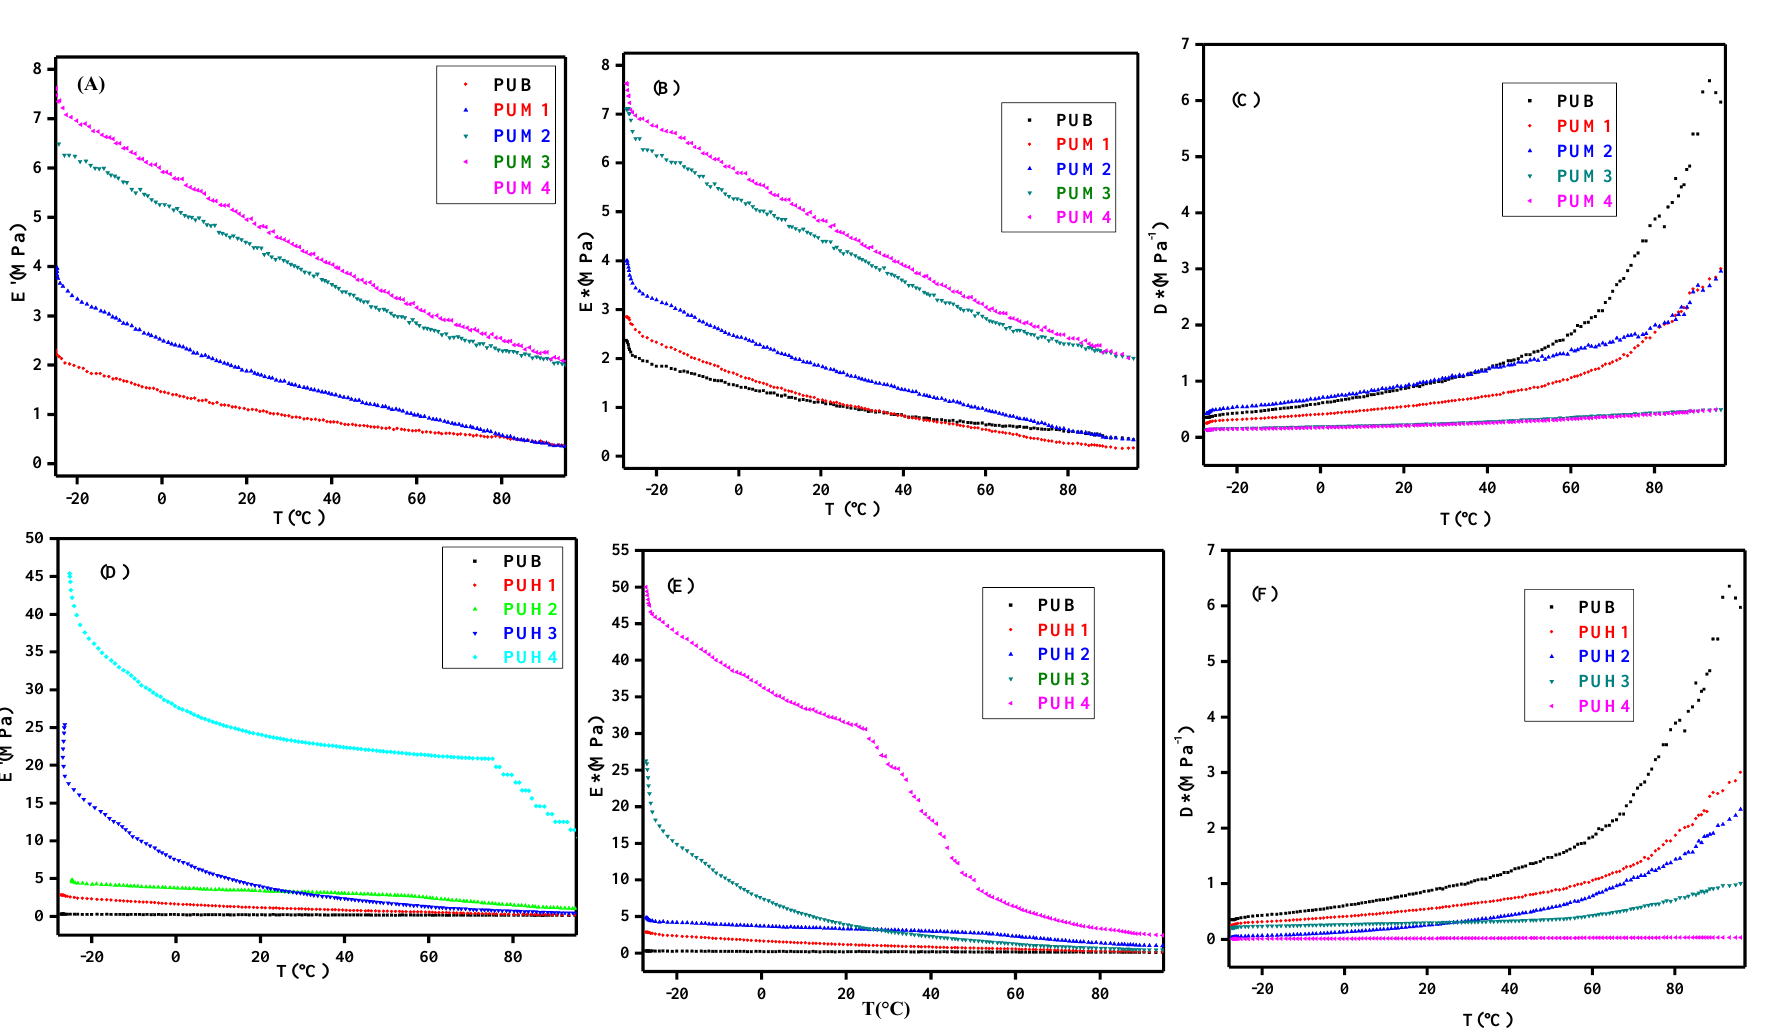
Figure 4. Mechanical Behavior of GO induced PU composites for PUM and PUH series. ( A ) Relationship of storage modulus and temperature of PUM. ( B ) Relationship of storage modulus and temperature of PUM complex modulus. ( C ) Relationship of compliance complex and temperature of PUM. ( D ) Relationship of storage modulus and temperature of PUH. ( E ) Relationship of complex modulus and temperature of PUH. ( F ) Relationship of compliance complex and temperature of PUH.